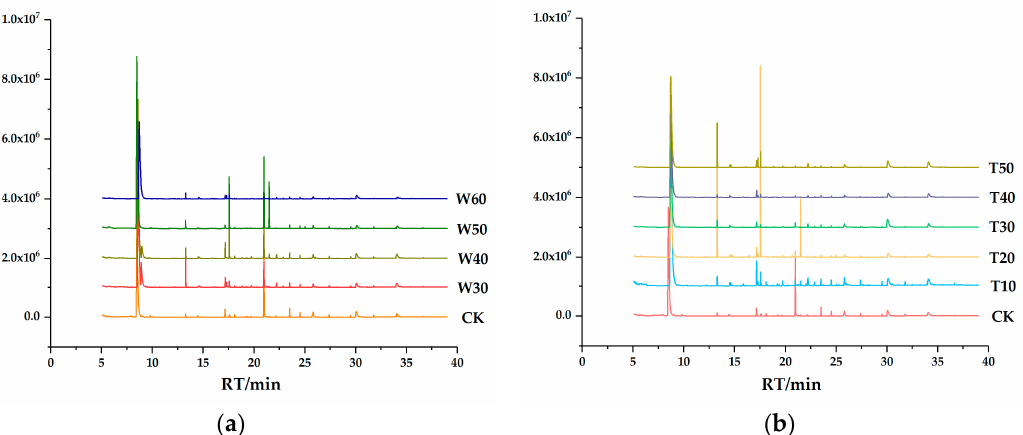
Figure 5. Comparison of TIC profile of the volatiles from the preprocessing skim milk samples. ( a ) The TIC profile of the volatiles from the skim milk samples produced by preheating at different temperature. ( b ) The TIC profile of the volatiles from the skim milk samples produced by preheating for different time.